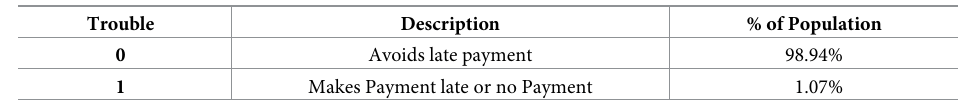
Table 3. Trouble variable